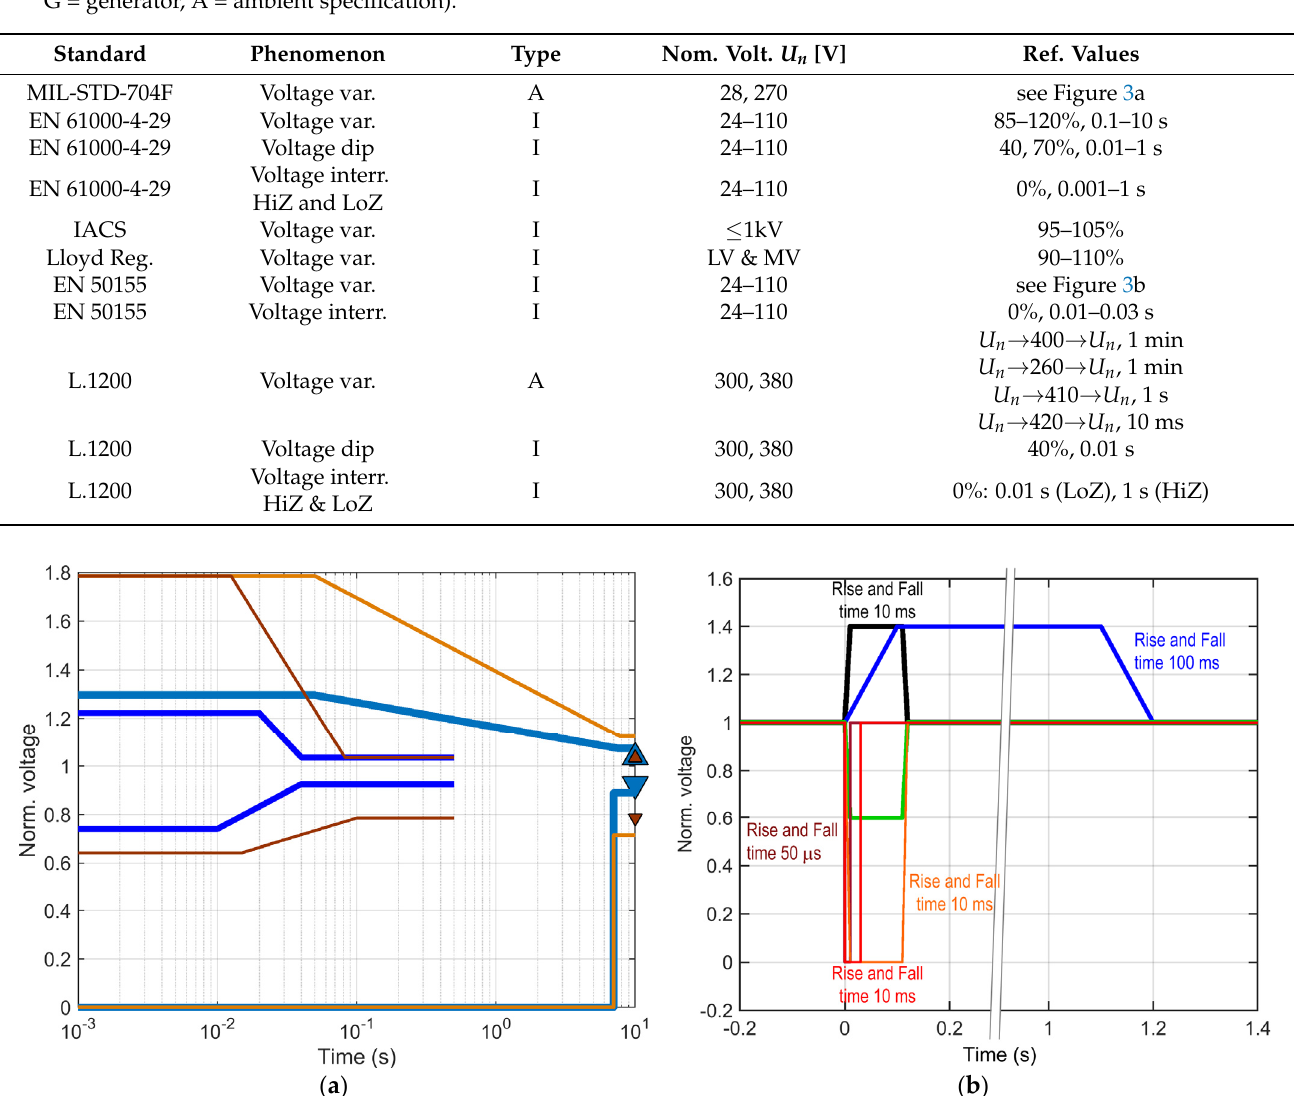
Table 5. Limits and test values for transient phenomena (voltage swells, sags, and interruptions) (E = emission, I = immunity, G = generator, A = ambient specification).